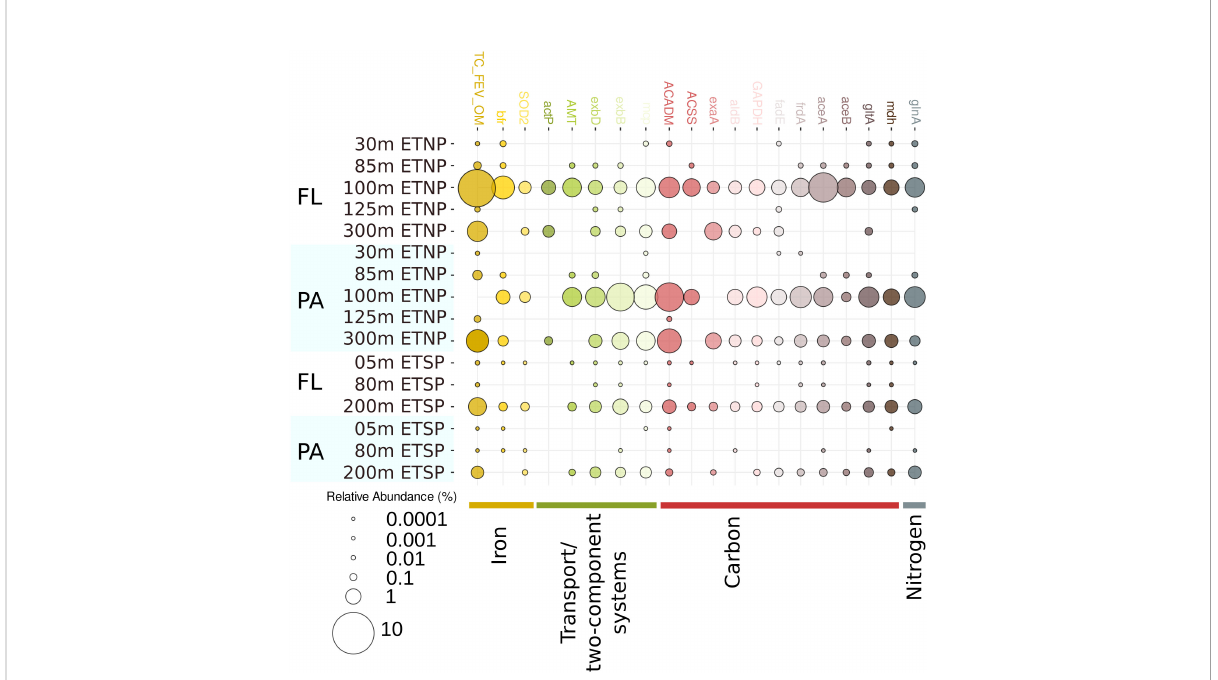
FIGURE 4 Percentage recruitment of ETNP and ETSP OMZs metatranscriptome read fragments to key Alteromonas functional genes. Alteromonas genomes and SAGs populations were used to recruit reads from the metatranscriptomic data from both the ETNP and ETSP using a cutoff of 97% nucleotide identity over a minimum alignment length of 100 nucleotides. the top 20 KEGG orthologs (KOs) were selected. FL, Free-living; PA, Particle-attached. Values for each KO were normalized by the fraction of KEGG assigned to Alteromonas from the total KEGG assigned in each